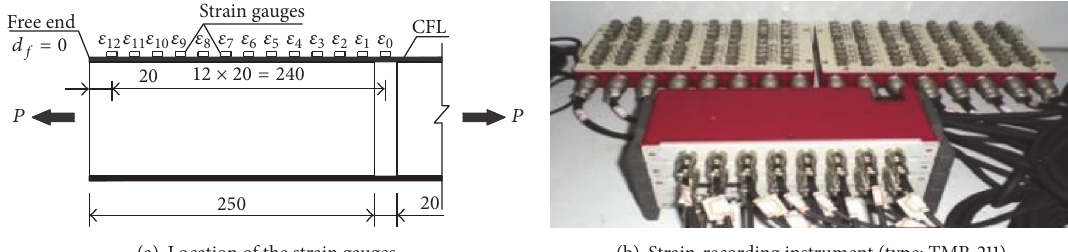
Figure 6: Measurement of strain.